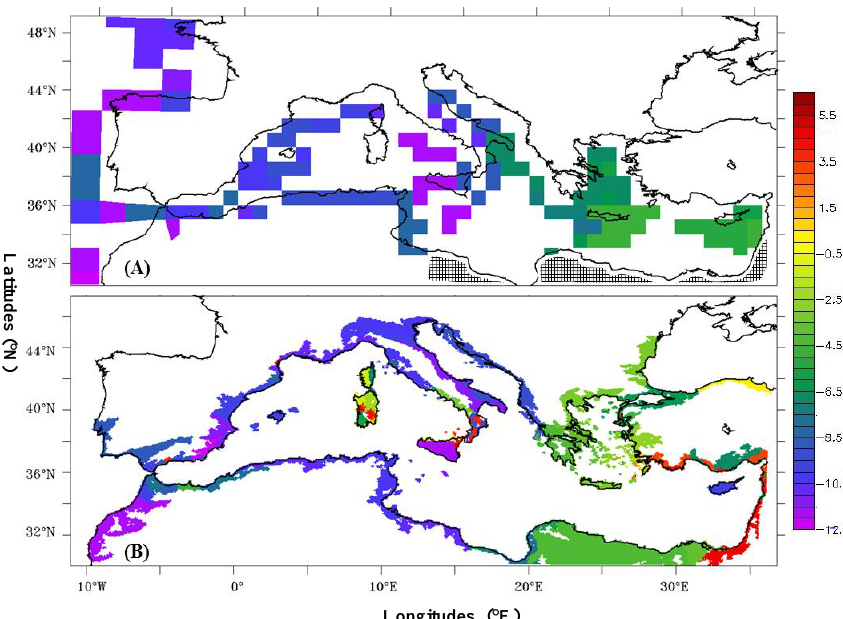
Figure 2. Extrapolated map providing a picture of the Nd signature of all the margins surrounding the Mediterranean Sea. (a) Low-resolution configuration ORCA2 (reproduced from Jeandel et al., 2007) and (b) high-resolution configuration NEMO-MED12 (this work). Hatched areas correspond to uncharacterized areas in the published literature (before 2007) as done by Jeandel et al.